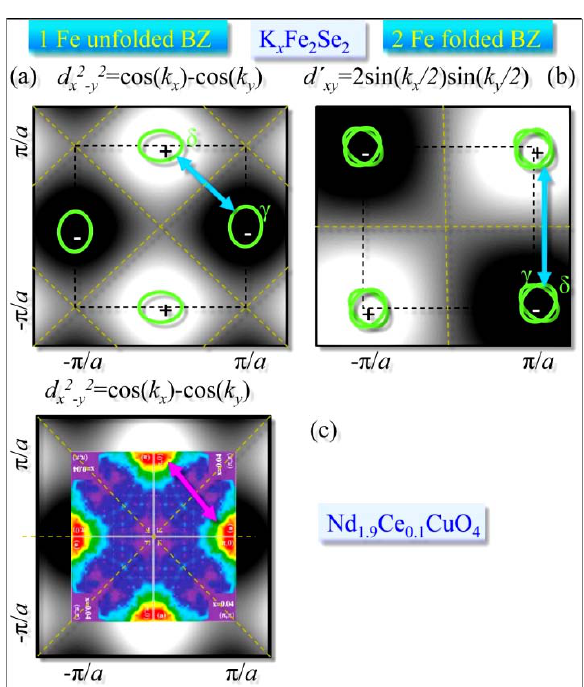
Fig. 3. (a), (b) Schematic FS and d -wave pairing for K y Fe 1.6 Se 2 system in the 1FUC and 2FUC, respectively. (c) ARPES results of FS (symmetrized on the whole Brillouin zone) for an electron-doped superconductor. Strong AFM order in underdoping eliminates the hole-pocket from the nodal region, and thus a nodeless d- wave pairing emerges in this cuprate system as in K y Fe 1.6 Se 2